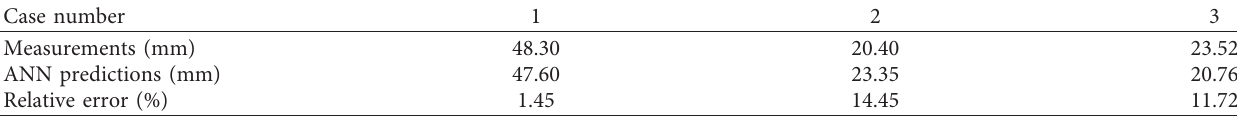
Table 3: Comparison between measured maximum deflections of retaining wall in case studies and ANN